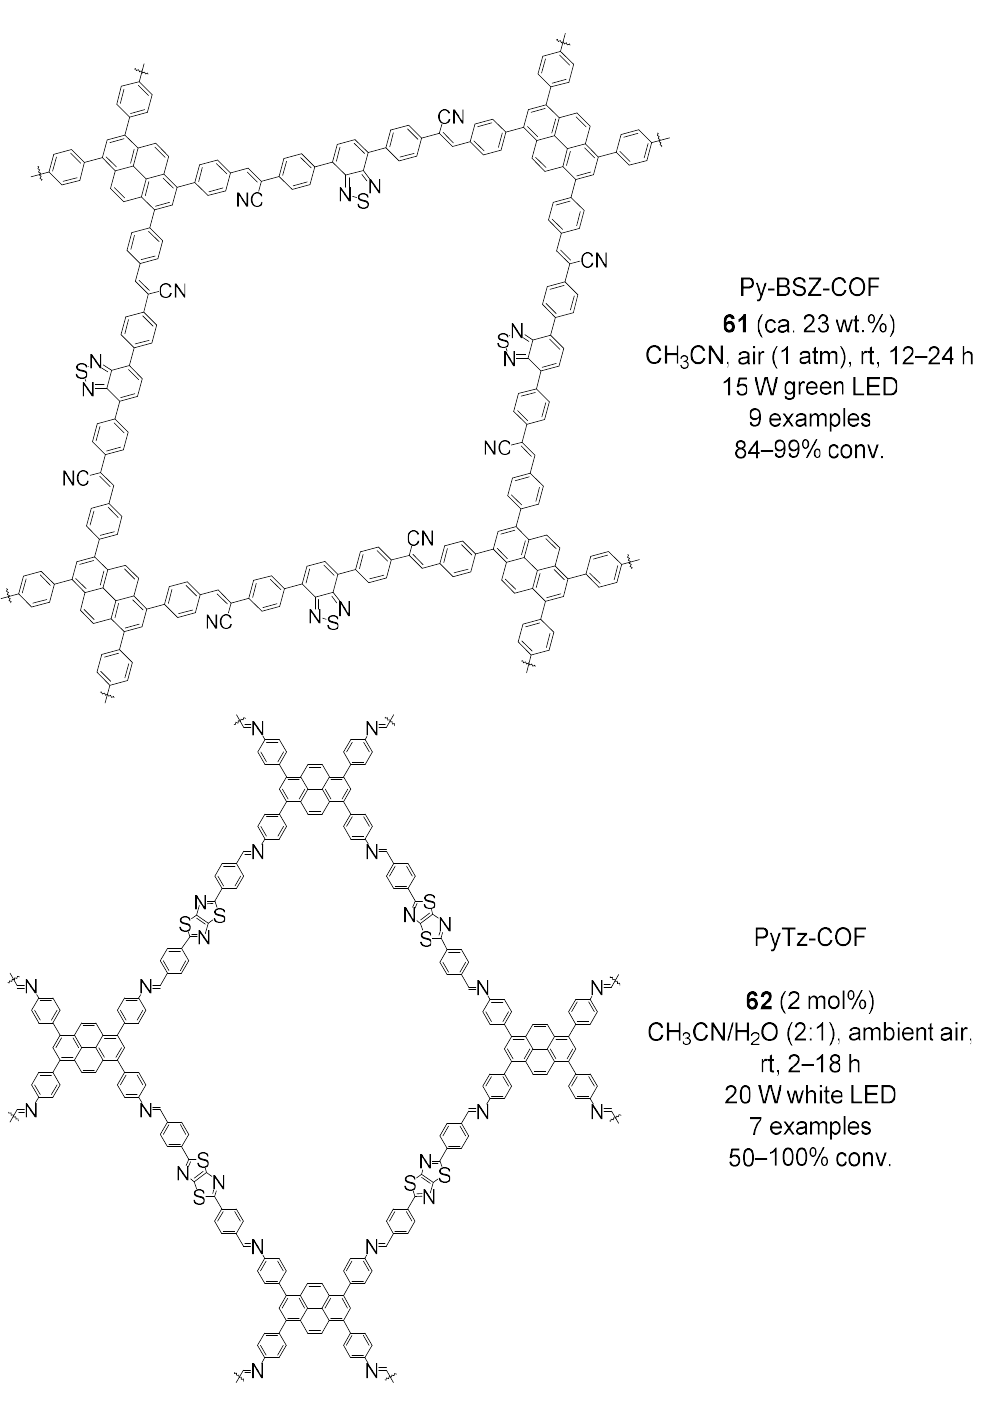
Figure 16. Results obtained in the aerobic photo-oxidative coupling of benzylamines to N -benzylidene benzylamines 2 catalyzed by 61 and 62 .